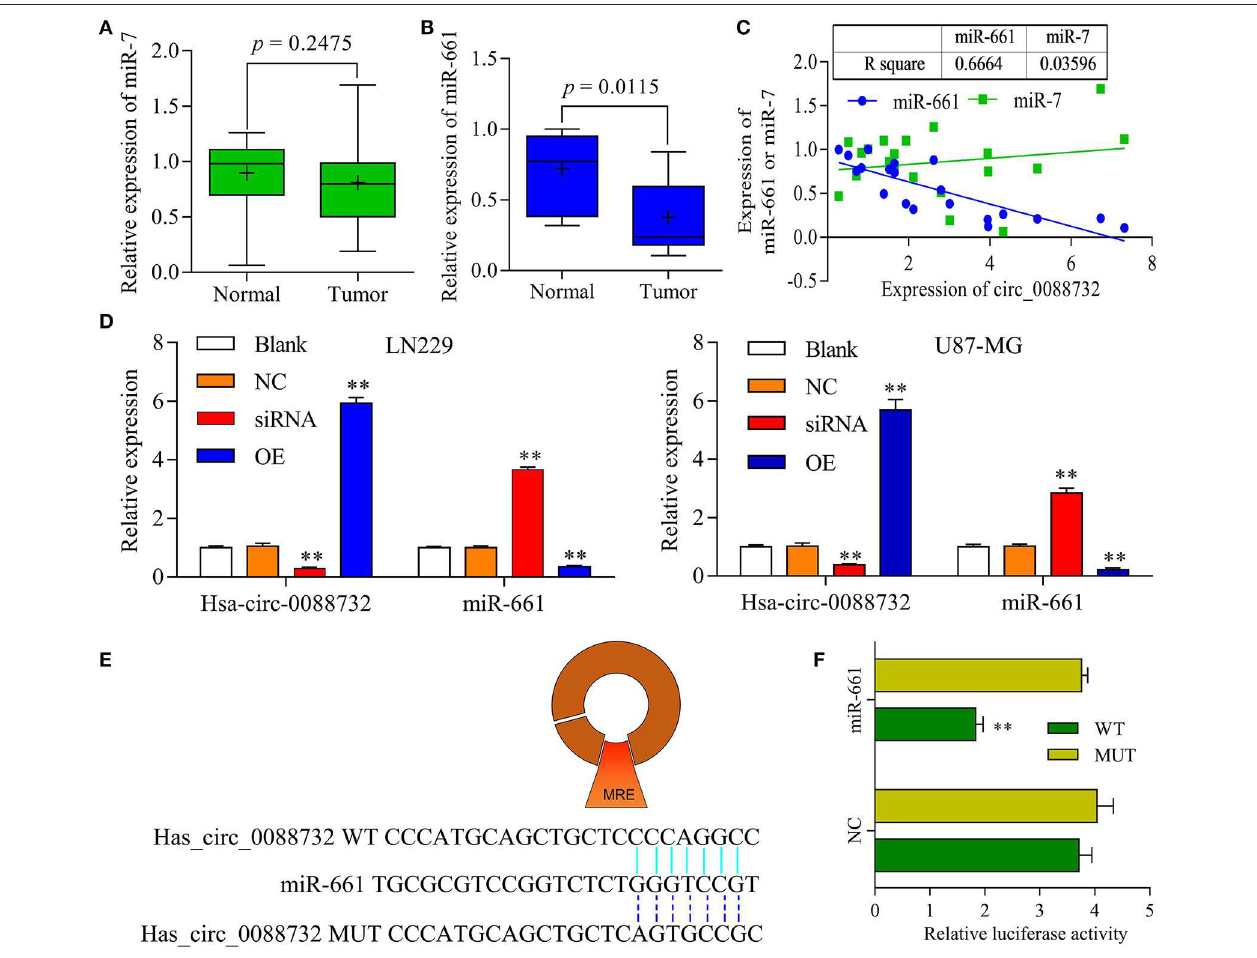
FIGURE 4 | hsa_circ_0088732 sponged miR-661 and negatively regulated miR-661 expression. (A,B) The levels of miR-7 and miR-661 expression in 20 pairs of glioma and adjacent non-tumor tissues were analyzed by qRT-PCR. (C) Person’s correlation coefficient was used to analyze the correlation between hsa_circ_0088732 and miR-7 (R 2 = 0.03596) and miR-661 (R 2 = 0.6664). (D) LN229 and U87-MG cells were transfected with hsa_circ_0088732 siRNAs or overexpression plasmids, respectively. hsa_circ_0088732 and miR-661 expression were analyzed by qRT-PCR assays (** P < 0.01). (E) The potential targets of hsa_circ_0088732 were analyzed by a bioinformatics analysis, and a binding site between hsa_circ_0088732 and miR-661 was identified. (F) 293T cells were co-transfected with WT-hsa_circ_0088732 or MUT-hsa_circ_0088732, and with miR-661 or the NC, and the relative levels of luciferase activity were analyzed (** P < 0.01). NC: negative control, siRNA: hsa_circ_0088732 siRNAs, OE: hsa_circ_0088732 overexpression